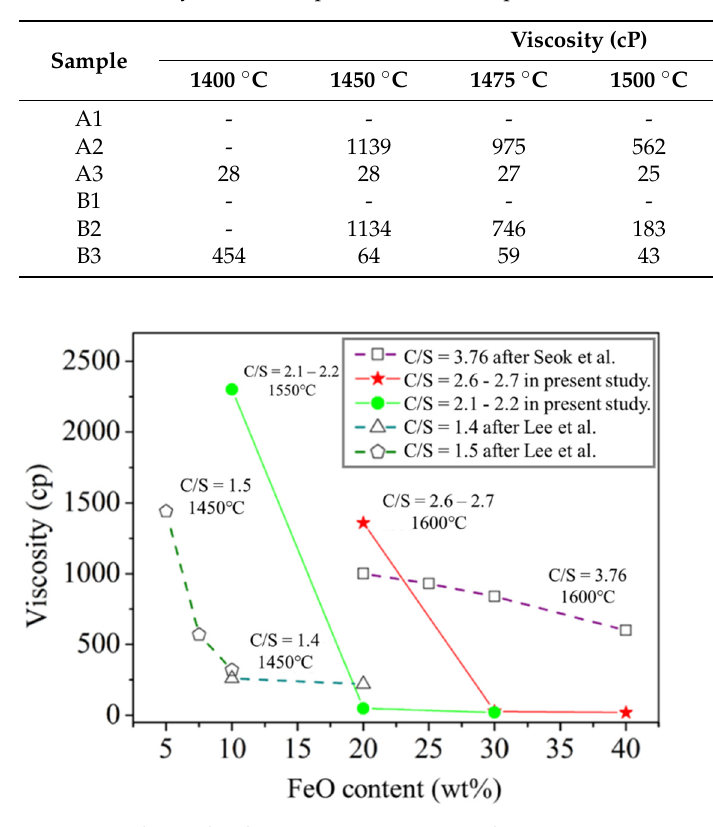
Figure 6. Relationship between FeO content and viscosity.